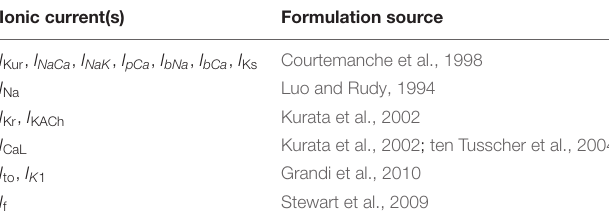
TABLE 1 | Summary of sources (References) to adopted model formulations.